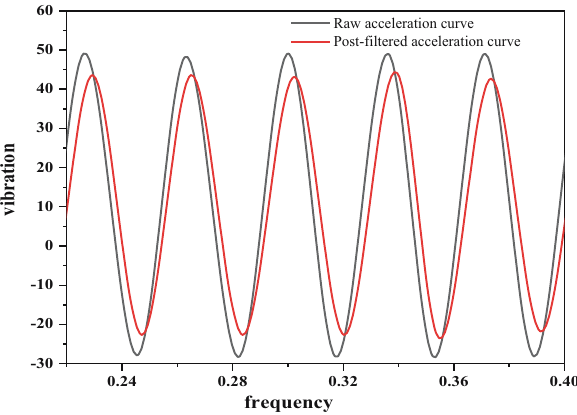
Figure 3: Curve comparison diagram of 80 Hz and 300 μ m amplitude acquisition data fi ltering.